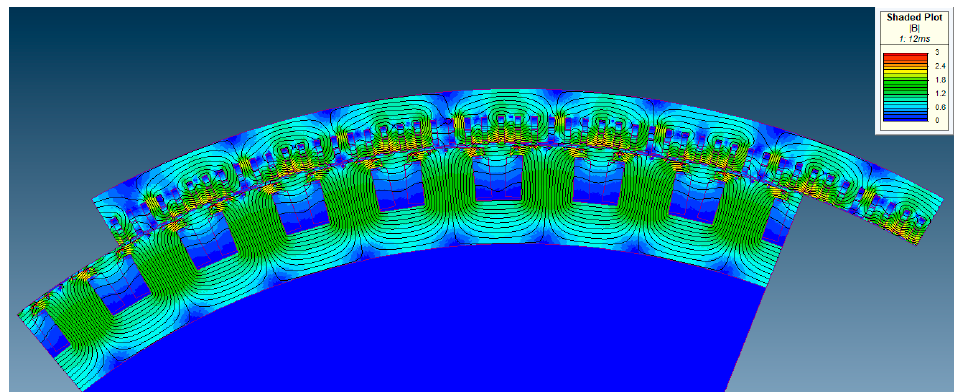
Figure 9. No load magnetic field.